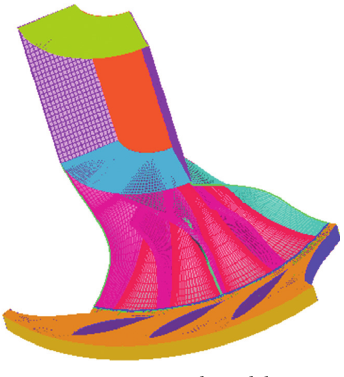
Figure 8: Grid model.